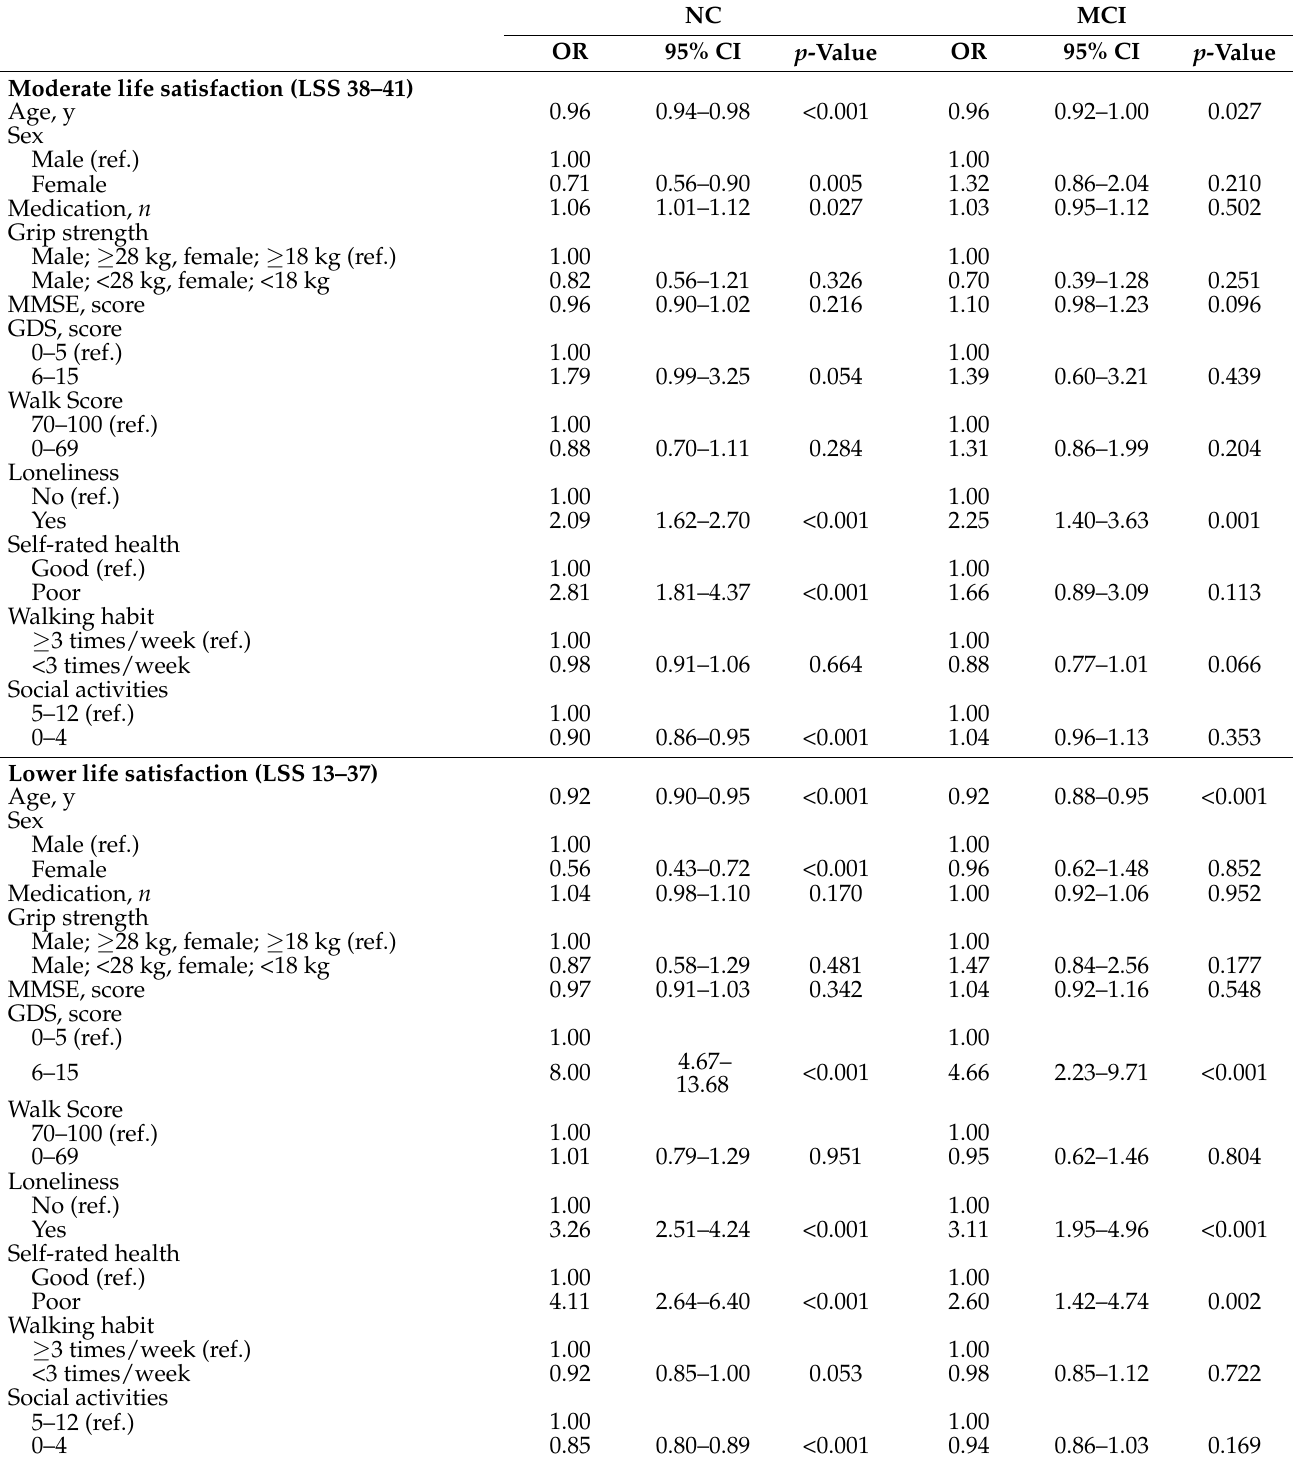
Table 4. Multinomial logistic regression analysis with cognitive status as the dependent variable by the level of life